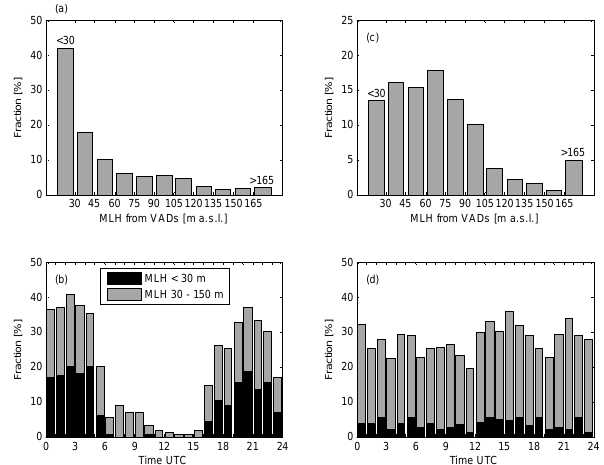
Figure 9. Histogram of MLH derived from VADs for the cases when vertical measurements indicate MLH to be below the low- est usable range gate in vertically pointing measurement mode for Limassol (a) and Loviisa (c) . The minimum range for MLH cal- culation from vertical measurements was 120ma.s.l. at Limassol and 159ma.s.l. at Loviisa. (b) Diurnal frequency of low MLH at Limassol. (d) Diurnal frequency of low MLH at Loviisa. The mini- mum range for MLH calculation from VADs was 30ma.s.l. at both Limassol and